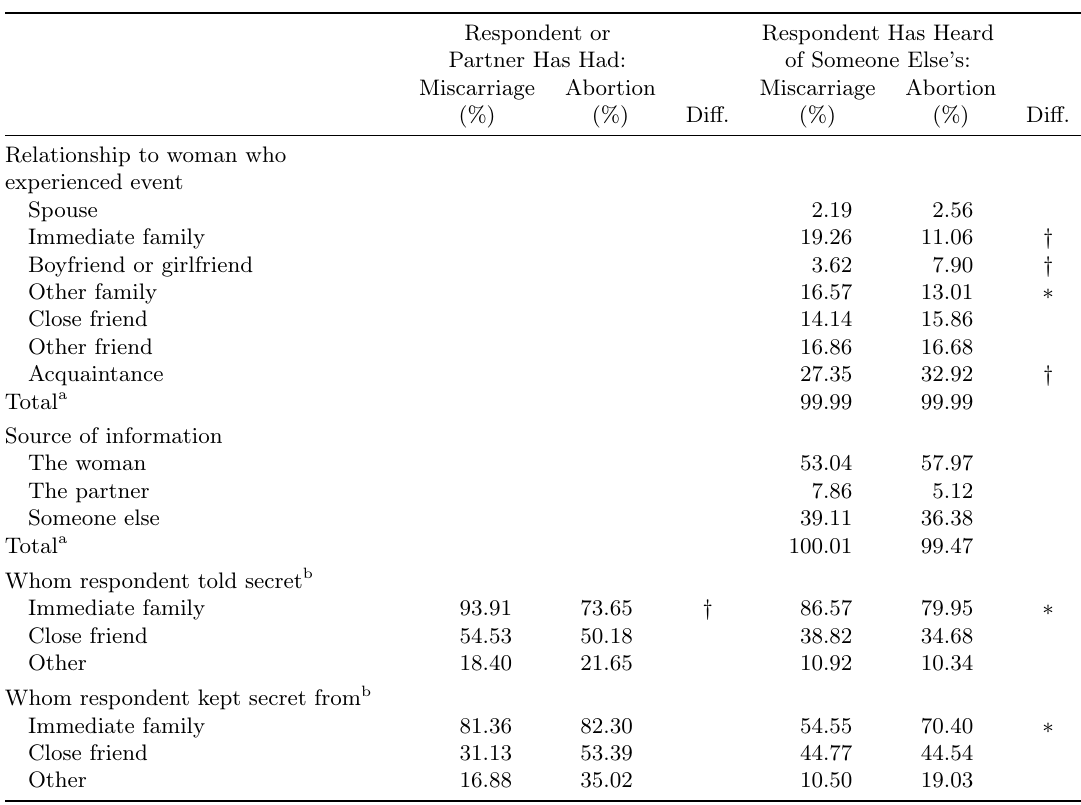
Table 2: Relationship Patterns of Secret Telling and Secret Keeping of Own and Others’ Miscarriages and Abortions, AMACS